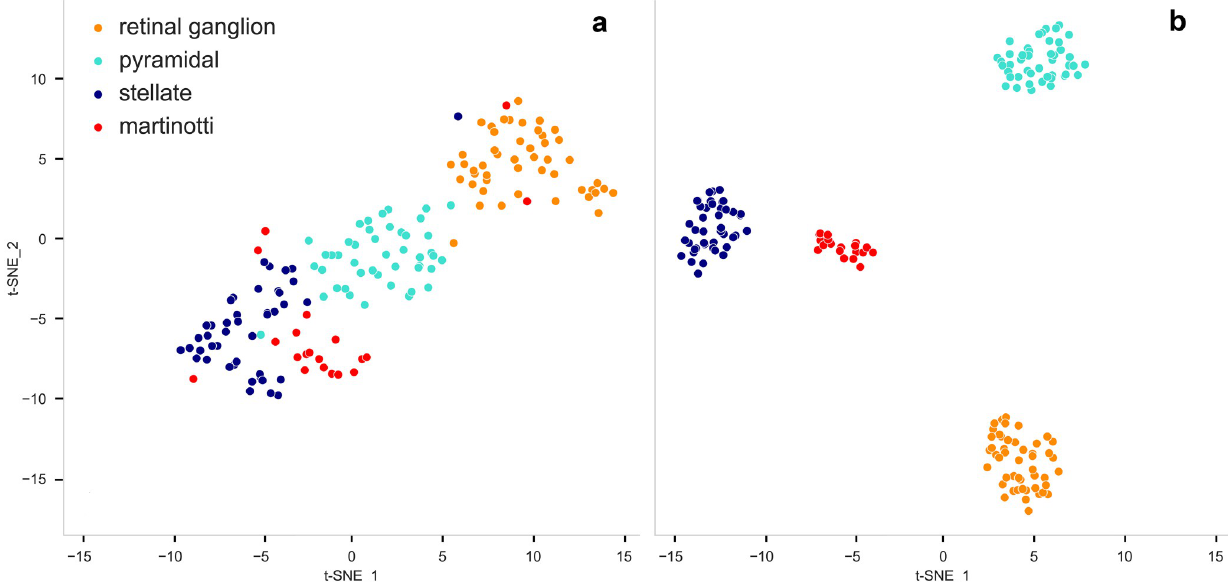
Fig 7. Classification and Metric learning for Dataset 1. Each dot represents a neuron which is color coded according to its class. tSNE was performed to reduce dimensions. ( a ) Vectorized neurons in Euclidean space. ( b ) Large Margin Nearest Neighbor (LMNN) classification for metric learning classification in the new metric